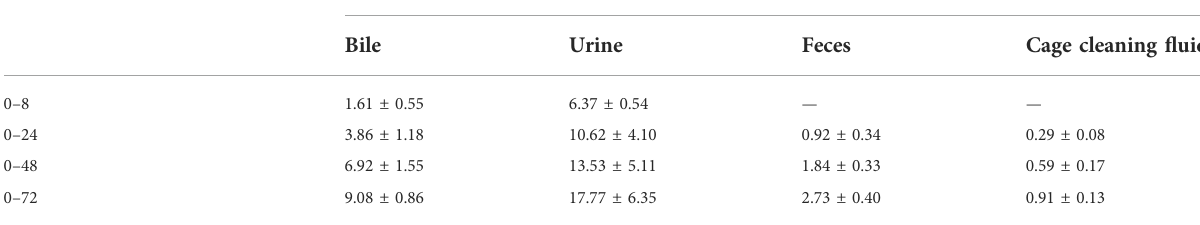
TABLE 8 The recovery of total radioactivity in bile, urine, feces, and cage cleaning fl uid during 0 – 72 h after intramuscular administration of [3H] BPC157 in BDC rats. Time interval (hour)